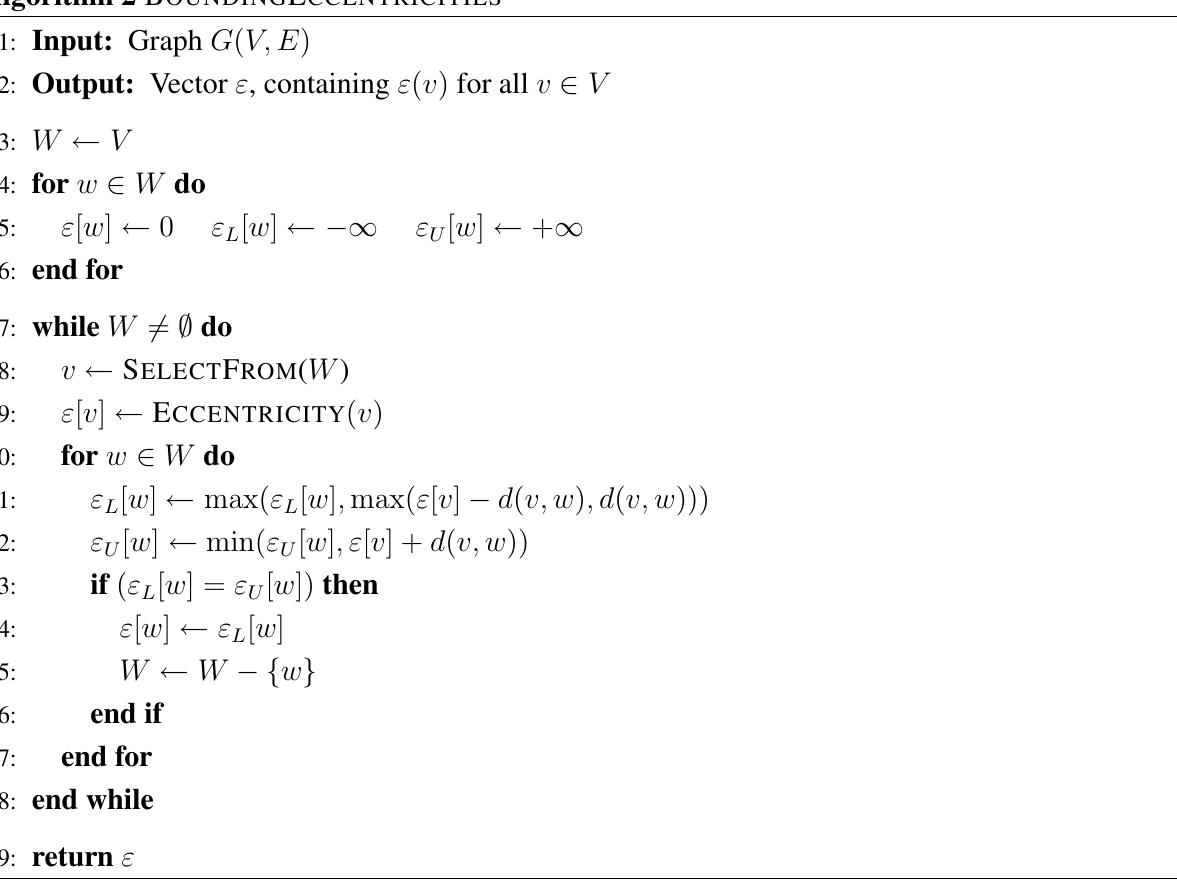
Algorithm 2 B OUNDING E CCENTRICITIES